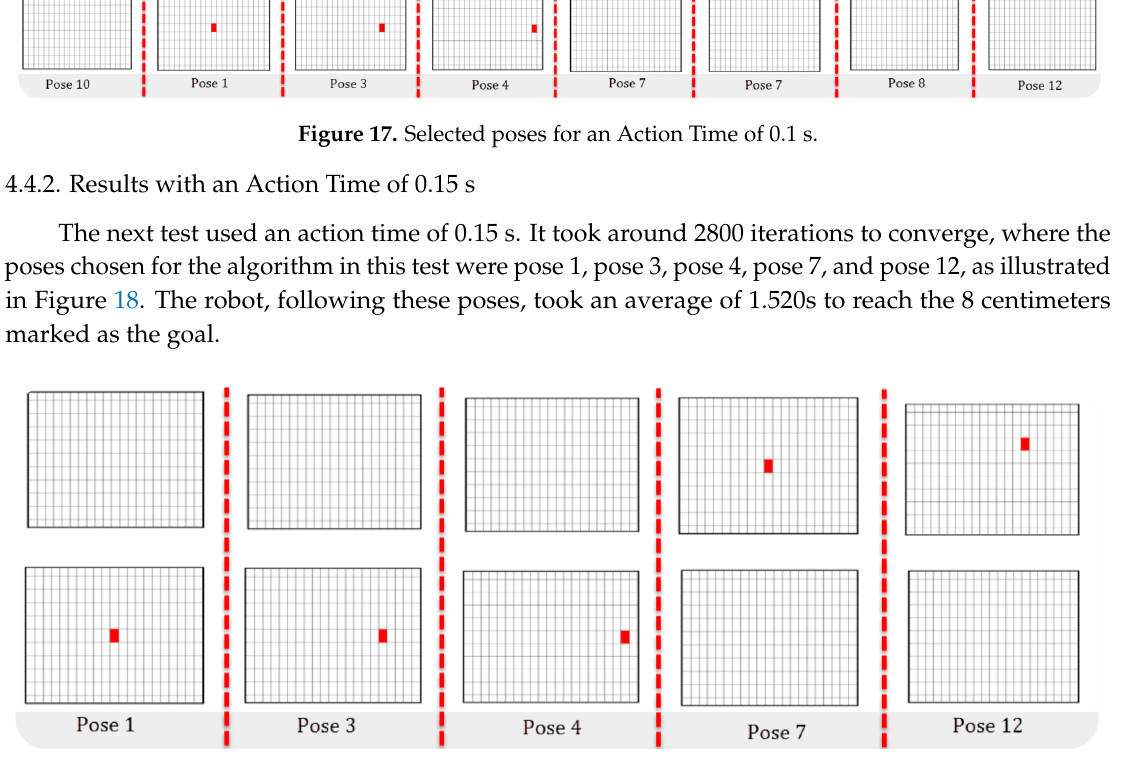
Figure 18. Selected Poses for an Action Time of 0.15s.